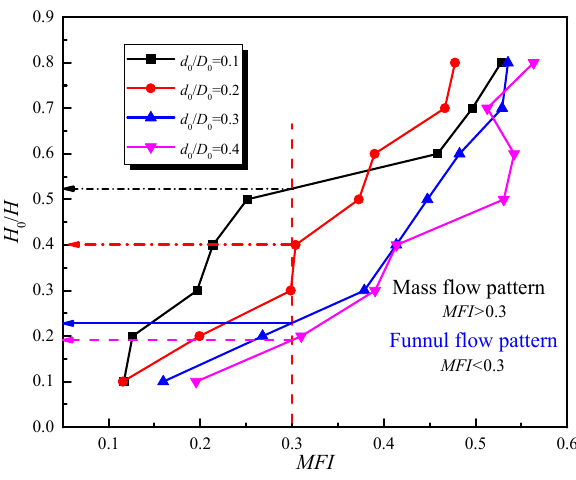
Figure 12. The variation in MFI in sinter layers with different normalized outlet scales.